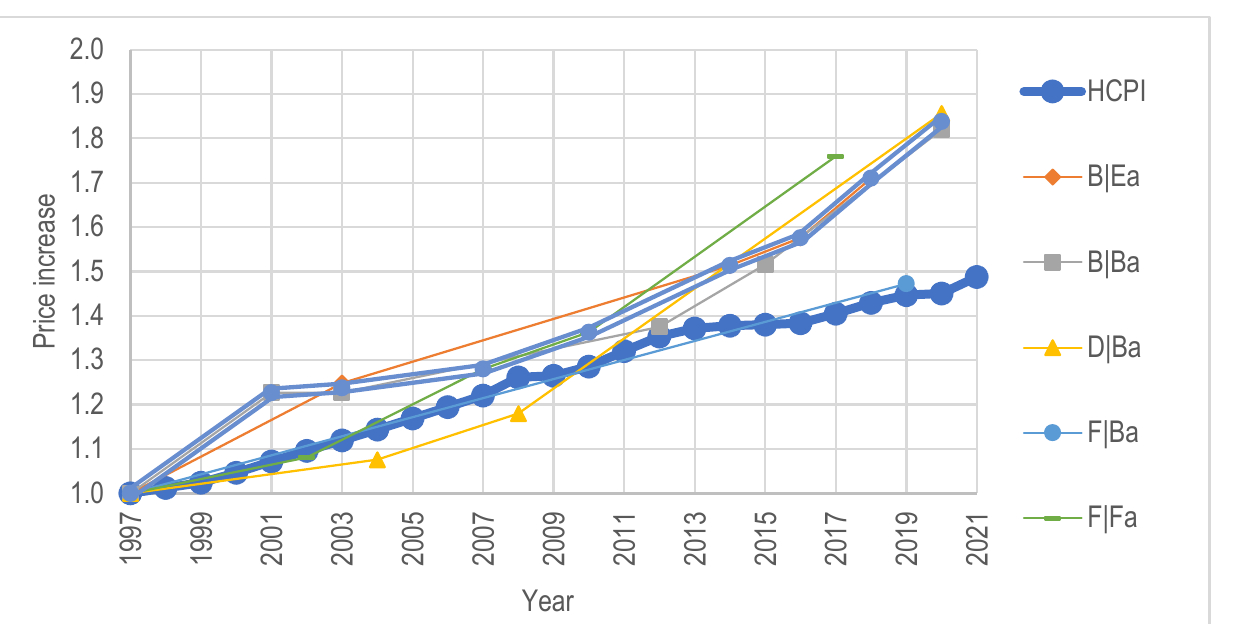
Figure 3. Combine list prices in Germany compared to Euro zone inflation (HICP) (1997 HICP and price increase value reference as 1).